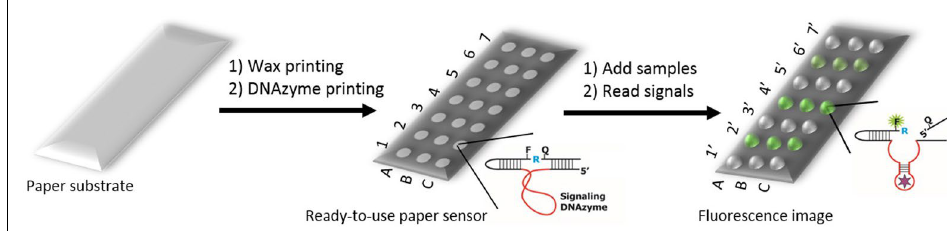
Figure 3. Representation of paper sensors principle. In each microzone, DNAzyme sensors are printed. Then, biological samples are deposited into test zones. If a sample contains the target bacteria, the DNAzyme produces a fluorescent signal. This figure is a partial reproduction from reference [77], licensed under CC BY 4.0.